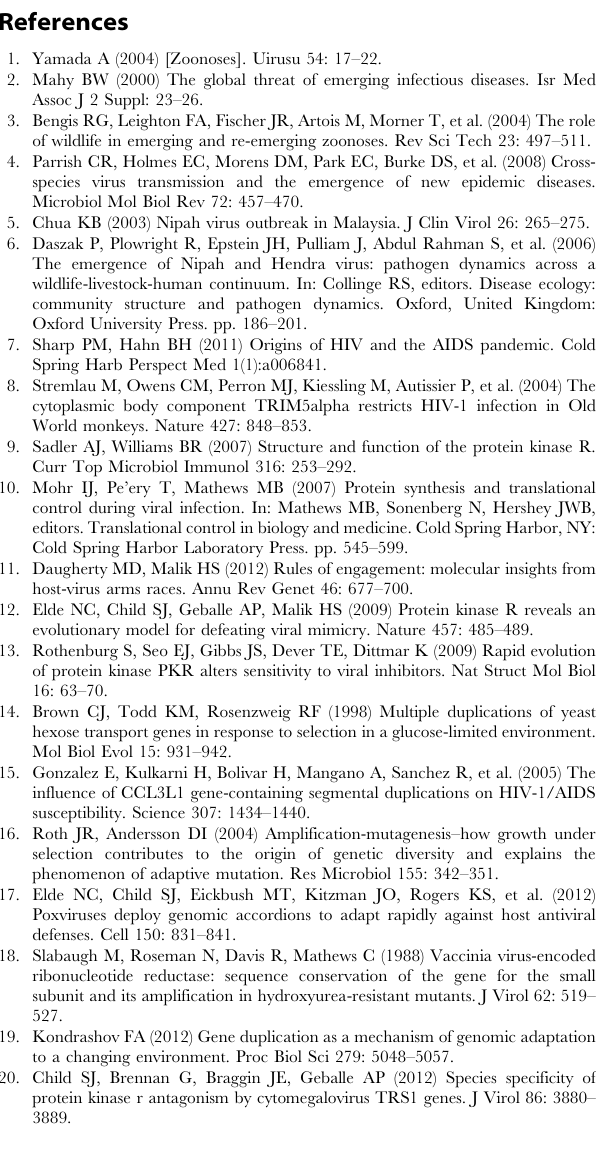
Table S3 Mutations identified in VV-A, VV-B and VV-C after four passages through HFF relative to vaccinia virus (strain